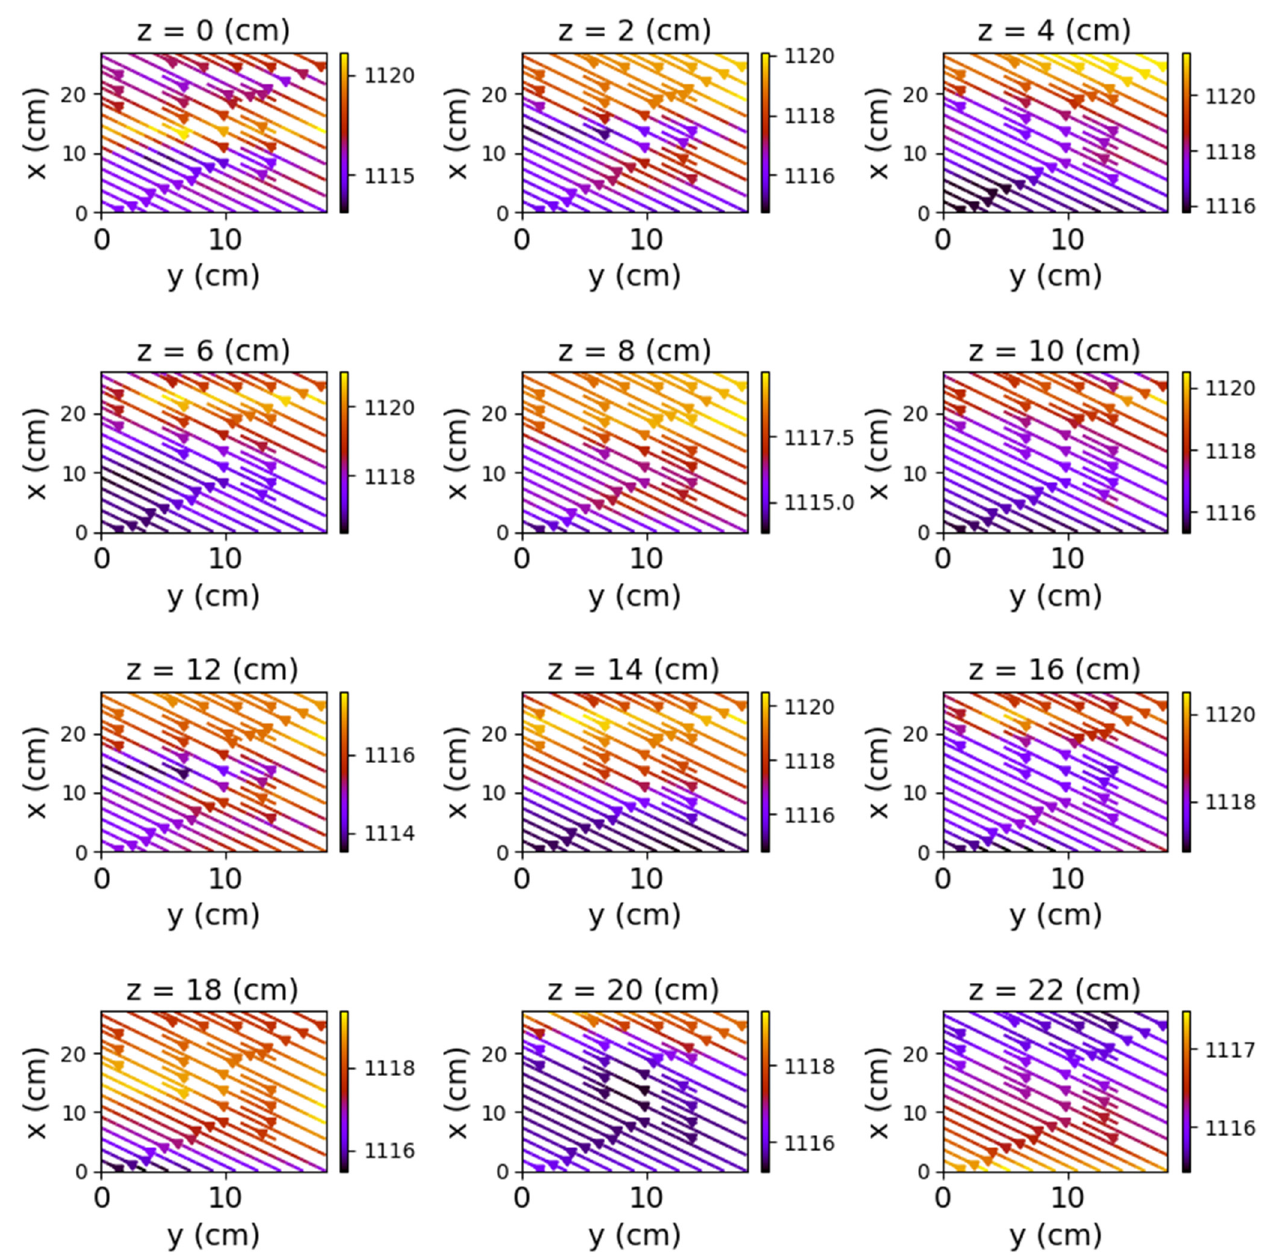
Figure 17. Field lines for x O y plane—relay with coil 1–3 powered.